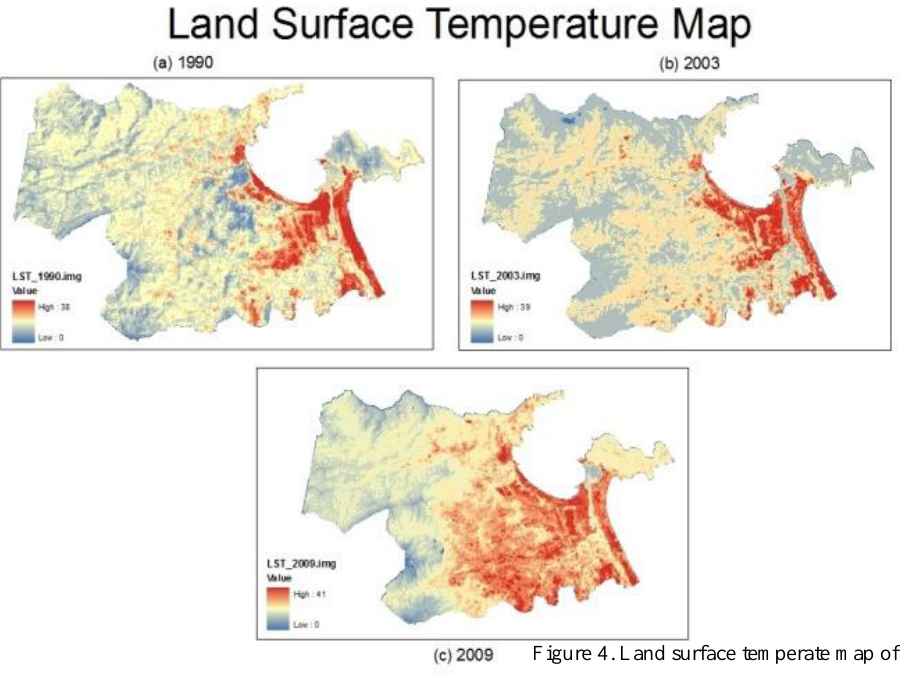
Figure 4. Land surface temperate map of Danang